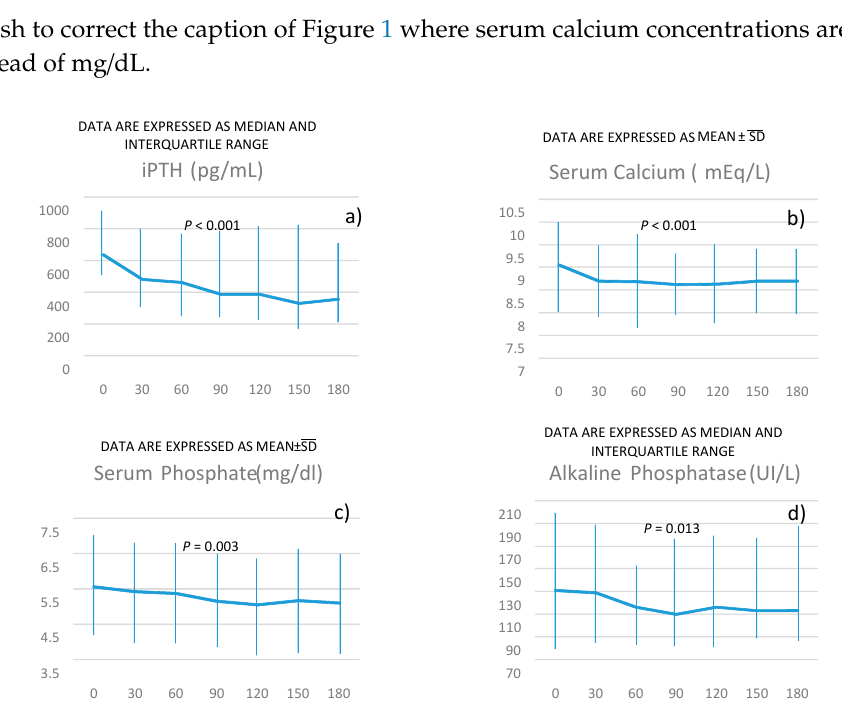
Figure 1. P for the trend of intact parathyroid hormone (iPTH) (panel a ), serum calcium (panel b ), serum phosphate (panel c ), alkaline phosphatase (panel d ) over time was obtained using linear regression models weighted for patients’ identification (see methods for more details).